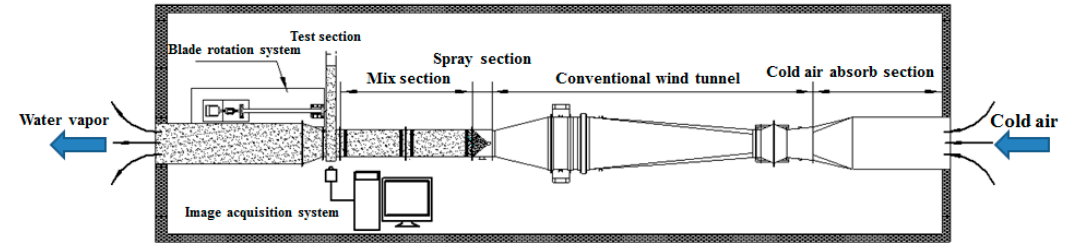
Figure 2. Schematic diagram of icing wind tunnel experiment system